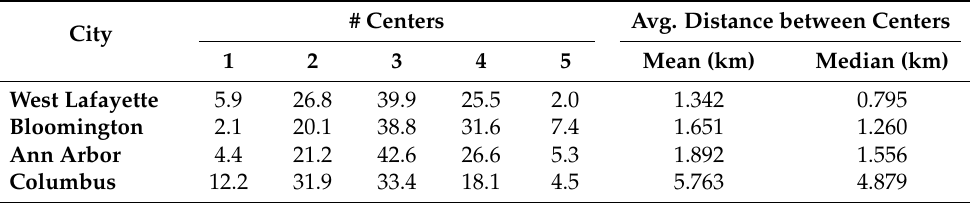
Table 5. Percentage users of different spatial clusters and their distances.